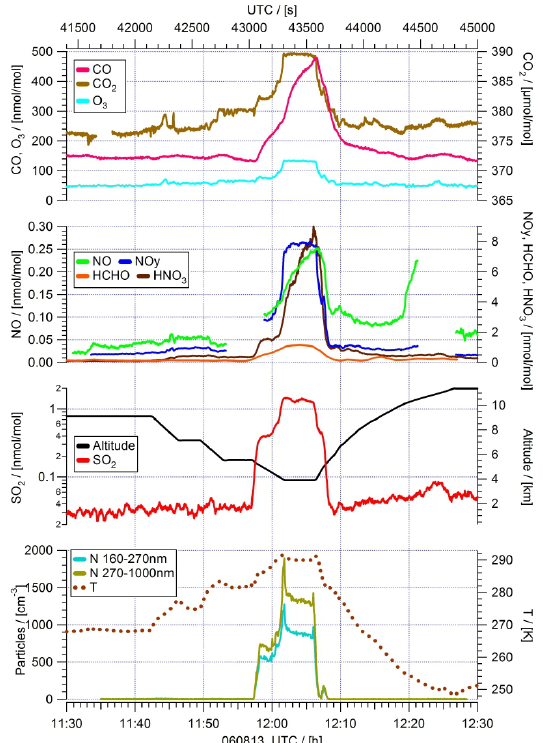
Fig. 5. Time sequences of measured atmospheric trace gases and particles. Panel 1: CO, CO 2 and O 3 mole fractions. Panel 2: NO, NO y , H 2 CO and HNO 3 mole fractions. Panel 3: SO 2 mole frac- tion and flight altitude. Panel 4: Number concentration of aerosol particles possessing diameters from 160 to 270nm and from 270 to 1000nm. Also given is the outside air temperature T. Between 11:57 and 12:08 UTC the pollution plume is detected in all trace gases and in the